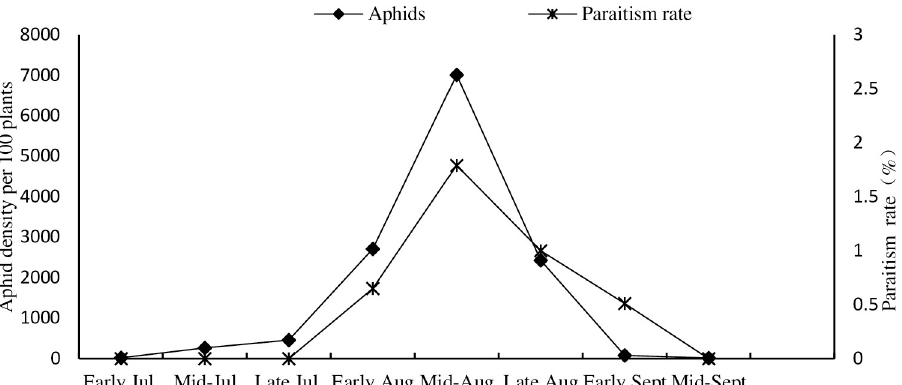
Fig 5. Maize field aphids density and parasitism